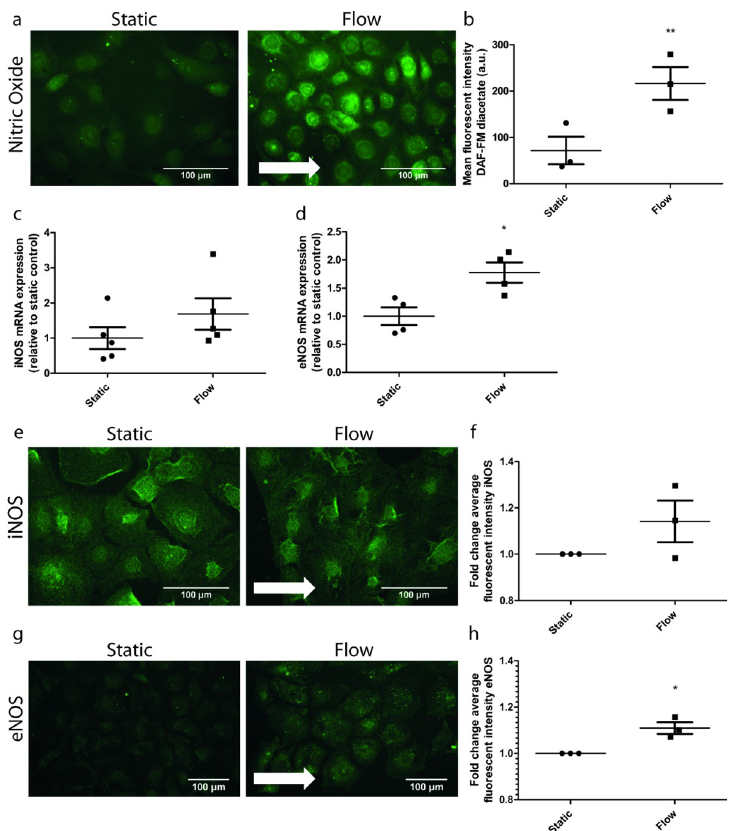
Fig 2. Laminar flow increases NO production in GEnCs. mGEnCs were cultured either under static conditions or under a laminar flow of 5 dyn/cm2 for 7 days. Representative images of stainings for NO (probed with DAF-FM diacetate) ( A ), iNOS ( E ) and eNOS ( G ) of mGEnC cultured under static (left panel) or flow (right panel). Arrows indicate the direction of the flow applied. Quantification of the fluorescent intensity of NO ( B ), iNOS ( F ) and eNOS ( H ) staining, respectively. mRNA expression levels of iNOS ( C ) and eNOS ( D ) in mGEnCs cultured under either static conditions or flow. � p < 0.05 �� p < 0.01.